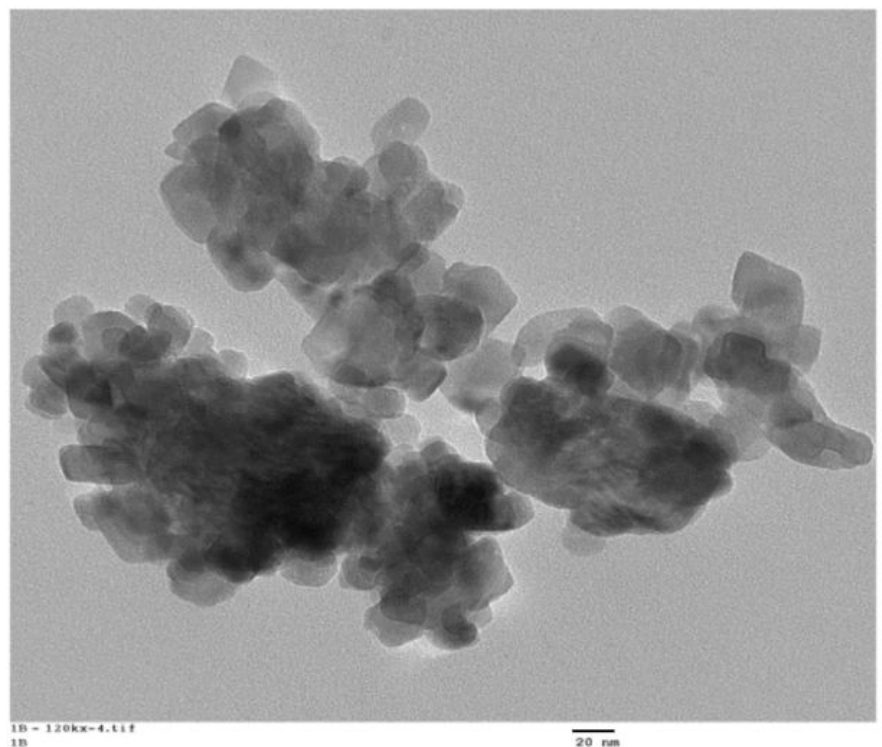
Figure 11. TEM image of calcium oxide nanoparticles obtained from eggshell waste adapted from (Render et al.